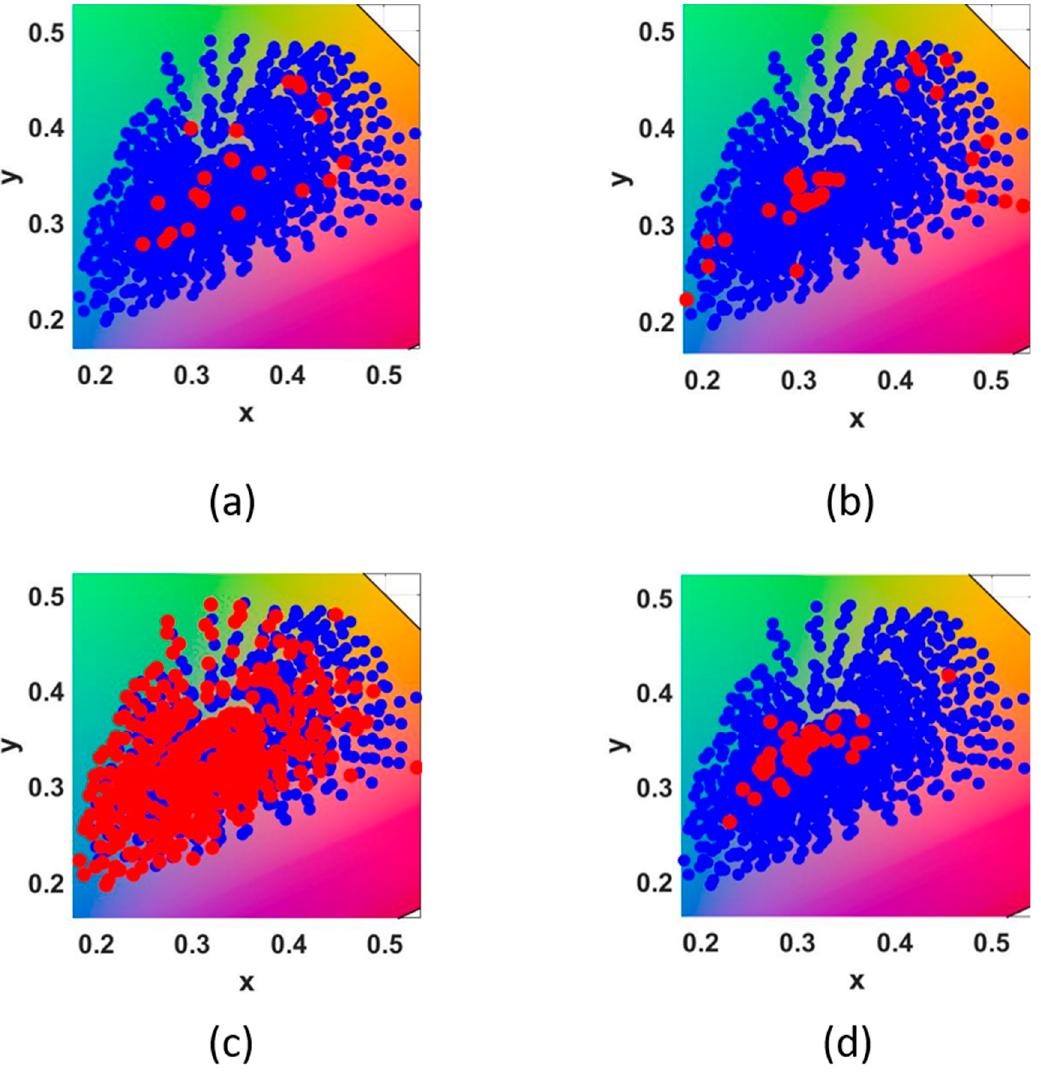
Figure 10. The distribution of training samples and representative points selected by four methods in xyY space, respectively: ( a ) the proposed, ( b ) Cheung [28], ( c ) Hardeberg [26] and ( d ) Liang [30].